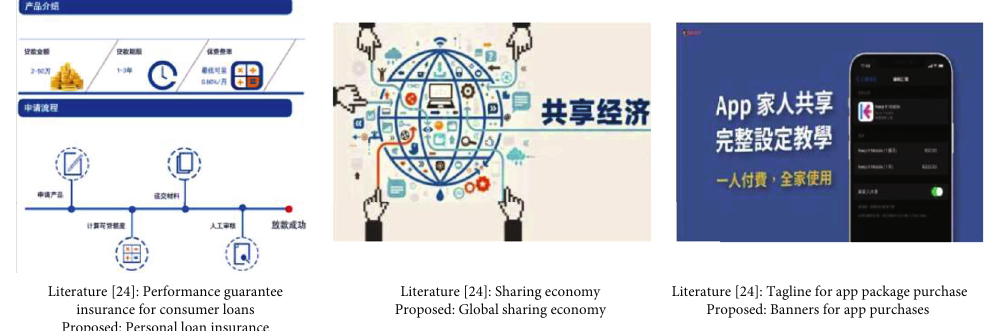
Figure 9: Comparison of recognizing multimedia image information between the proposed model and the model in literature [24].